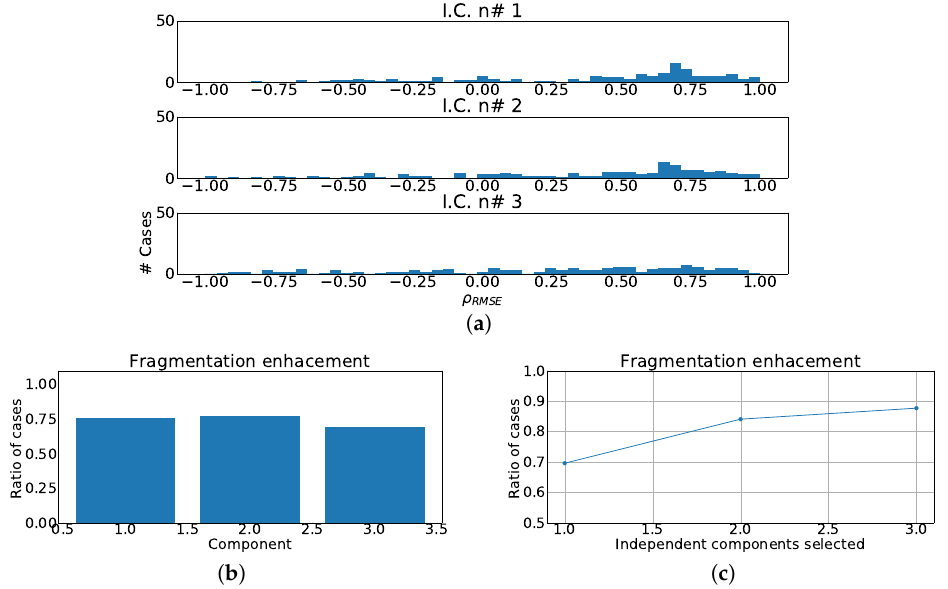
Figure 14. Different measurements for the inferior region of the heart with ICA model. ( a ) Distribution of ρ RMSE coefficient for each independent component, values lower than zero represents cases where the RMSE measured over the ECG is greater than RMSE measured over the independent component. ( b ) Ratio of fragmentation wave enhancement for each independent component, this ratio is computed as cases where the ρ RMSE value is greater than zero. ( c ) Cumulative ratio of fragmentation wave enhancement, this ratio is computed by joining the results of isolated independent